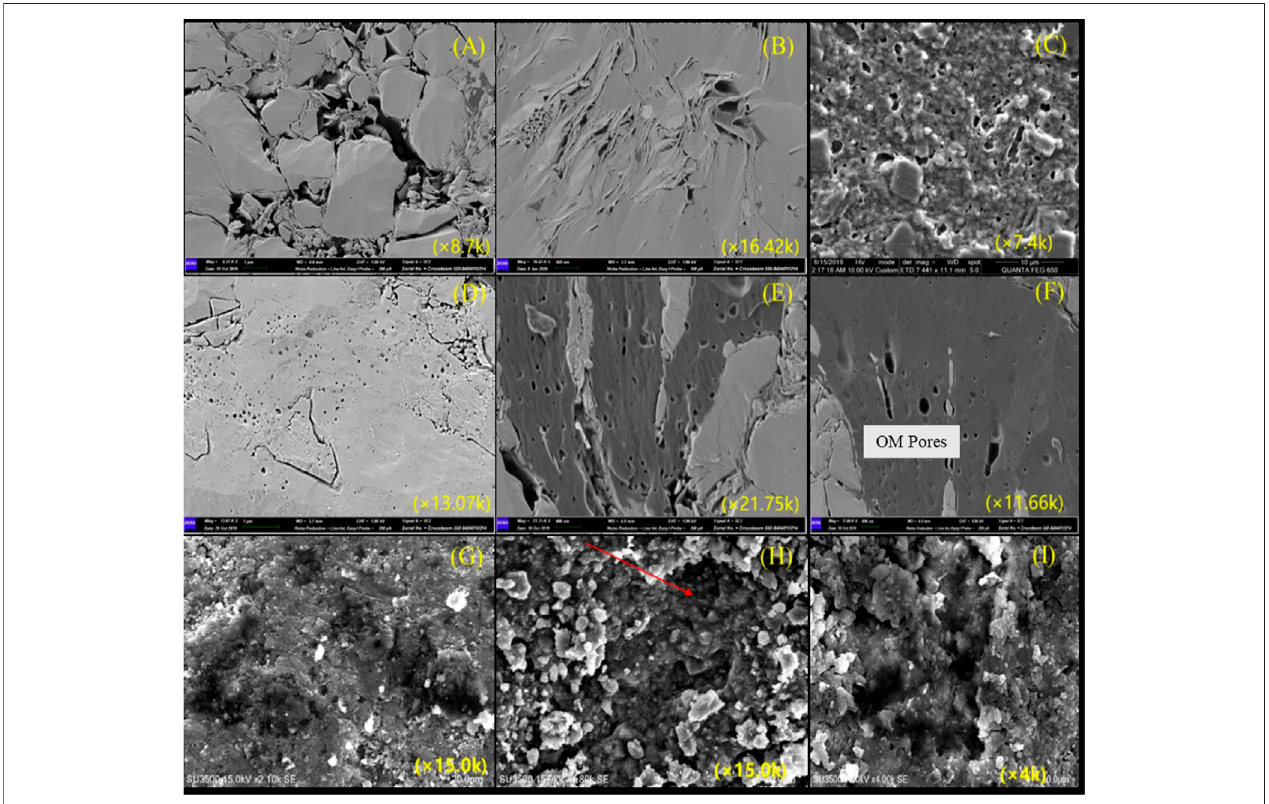
FIGURE 5 | Characteristics of shale micro-pore by SEM observation. (A) : G108-8, 3,040.6m, developed interparticle pores. (B) : GD14, 4,115.6m, developed intercrystalline and interparticle pores ofclay minerals. (C) : GD14, 4,121.9m, massivedolomitic shale facies with developed dissolution pores. (D) : G108-8, 3,040.63m, medium-organic laminar layered felsic dolomitic shale facies with well-developed pores. (E) : G108-8, 3,040.6m, organic matter pores. (F) : G108-8, 3,040.6m, organic matter pores. (G) : GD12, 3,880.9m, developed interparticle pores with oil. (H) : GD14, 4,135.5m, developed interparticle pores. (I) : GD 12, 3,880.9m, developed interparticle